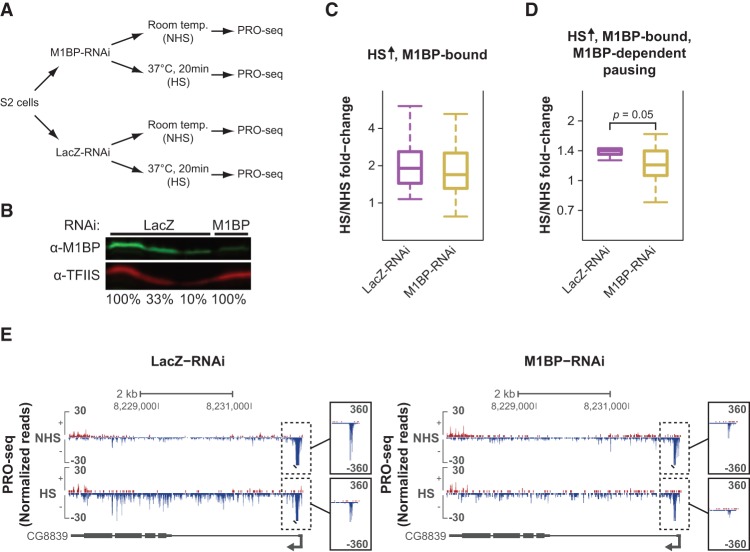
M1BP is important for pausing and HS activation of a subset of M1BP-bound genes with GAF-independent induction. (A) Experimental setup. Drosophila S2 cells were treated with either M1BP-RNAi or LacZ-RNAi for 5 d. Nuclei were then isolated for PRO-seq after cells were incubated at room temperature (NHS) or heat-shocked for 20 min (HS). (B) Western blot of whole-cell extracts from LacZ-RNAi-treated and M1BP-RNAi-treated cells using antibodies detecting M1BP and TFIIS (loading control). One-hundred percent is equivalent to 1.5 × 106 cells. (C) Box plot showing the HS/NHS fold change of M1BP-RNAi or LacZ-RNAi control cells for all M1BP-bound, HS-activated genes (HS ↑). (D) Box plot showing the HS/NHS fold change of M1BP-RNAi or LacZ-RNAi control cells for M1BP-bound, HS-activated genes with M1BP-dependent pausing. Mann-Whitney U-test, P-value = 0.05. (E) Representative view in the UCSC genome browser (Kent et al. 2002) of a gene with M1BP-dependent pausing prior to HS whose activation is decreased by M1BP-RNAi treatment. PRO-seq normalized reads for the different RNAi treatments (LacZ and M1BP) before and after HS for the plus strand are shown in red, and those for the minus strand are shown in blue. Gene annotations are shown at the bottom.